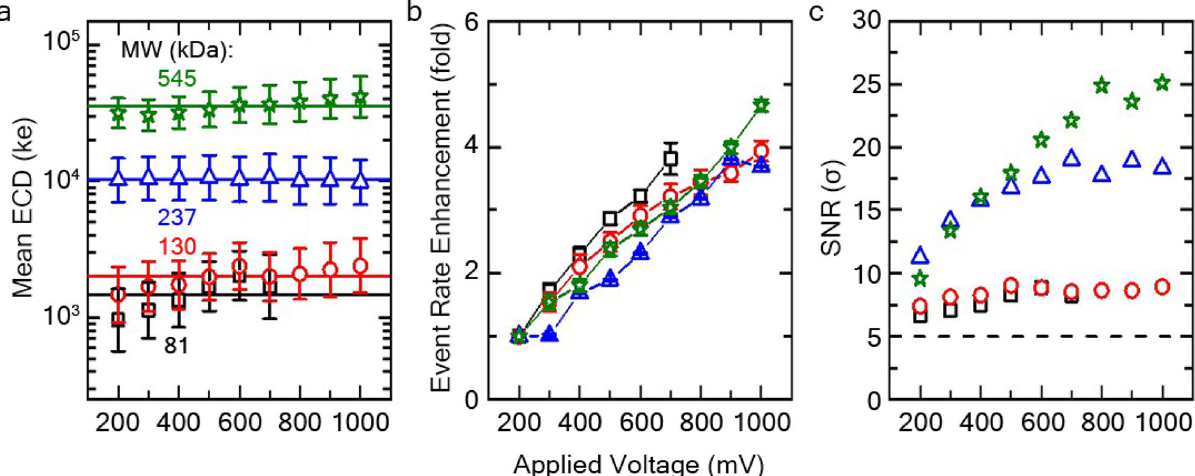
Figure 2. ( a ) Mean ECD of individual quasi-monodisperse HAs as functions of applied voltage. Lines represent the average value for each MW across all voltages. ( b ) Voltage-dependent event rate enhancement (relative to rate at 200 mV) for all MWs. ( c ) SNR for each MW across all voltages. Dashed line is threshold used for analysis. Colors: 81 (black squares), 130 (red circles), 237 (blue triangles), 545 kDa (green stars). Results collected using a single SS-nanopore (7.5 nm diameter) representing at least 2000 events for each data point. HA concentrations between 2.5–5 ng/μL were used. Error bars represent measurement standard